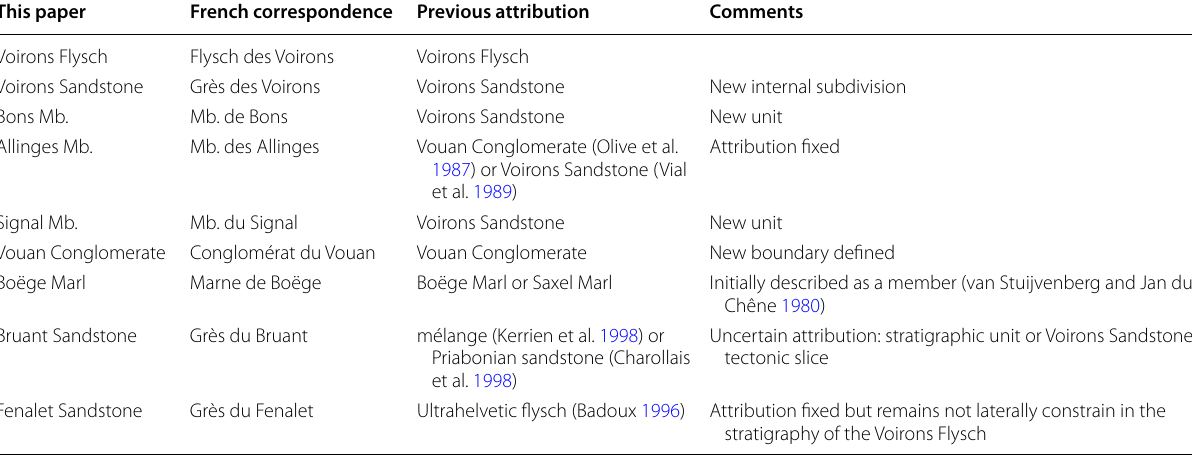
Table 1 Comparative table showing the name of the stratigraphic units defined in this work, the translation in French, and the names used in previous papers This